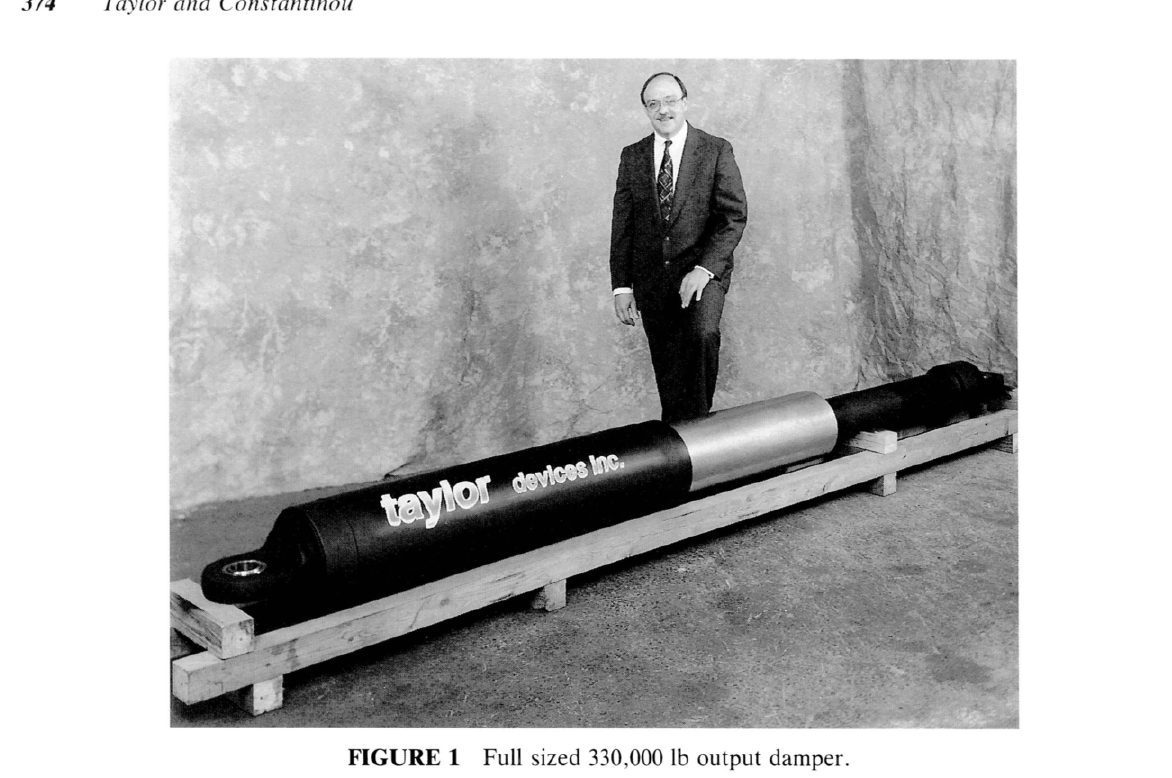
FIGURE 1 Full sized 330,000 lb output